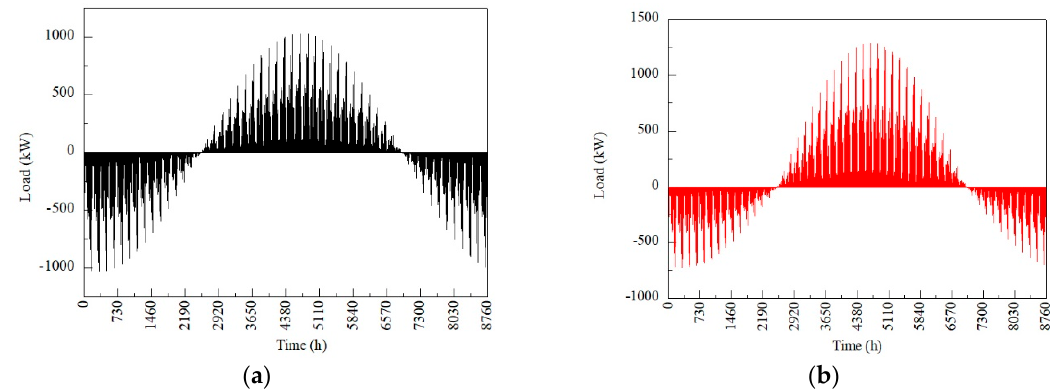
Figure 8. Hourly load information, including ( a ) building hourly loads and ( b ) ground hourly loads.